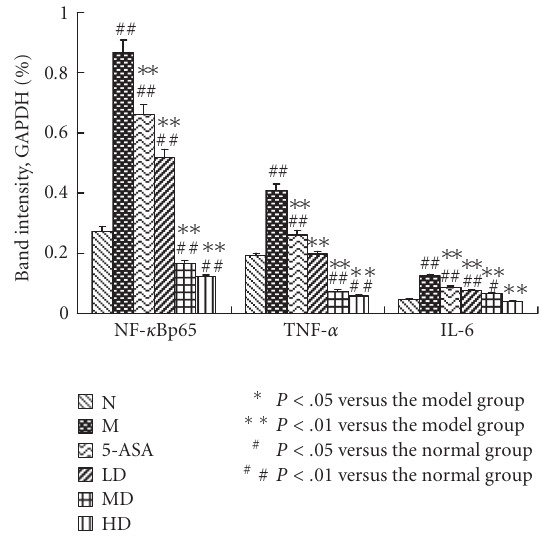
Figure 5: The Western blotting results of TNF- α , NF- κ Bp65, and IL-6 were measured by average ratios of TNF- α/β -actin, NF- κ Bp65/ β -actin and IL-6/ β -actin, respectively. The levels of TNF- α , NF- κ Bp65, and IL-6 of the M group showed a significantly high ex- pression compared with normal group. EGB treatment decreased the increase in a dose-dependent manner. The results were ex- SD. pressed as means (cid:0)